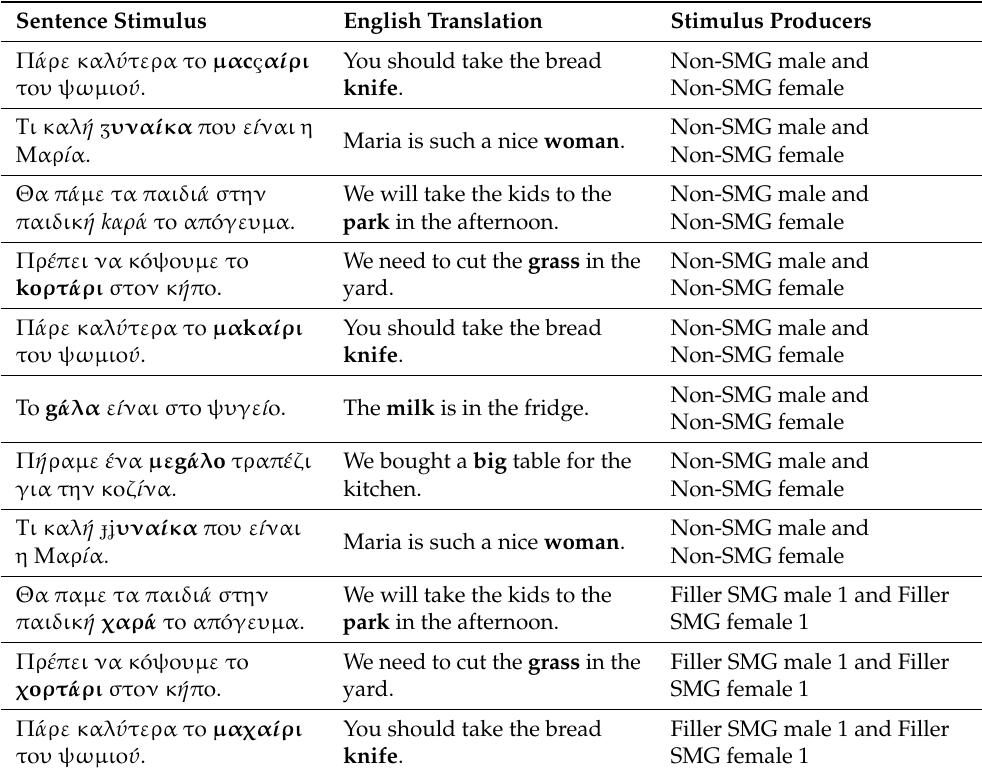
Table A1. IPA Symbols Mark Pronunciation Differences between the Sentences with the Same Semantic Content. Right-Most Column Indicates the Type (Non-SMG/SMG) of the Production and the Gender of the